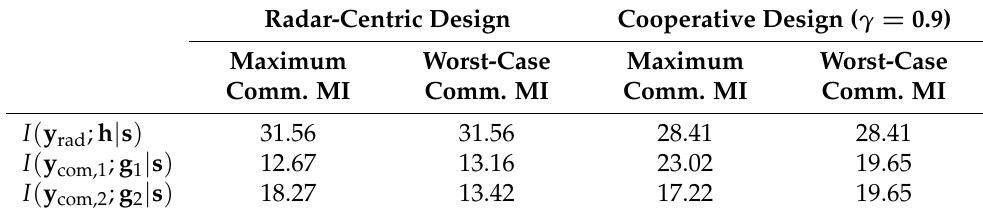
Table 1. Achieved mutual information for the proposed strategies.